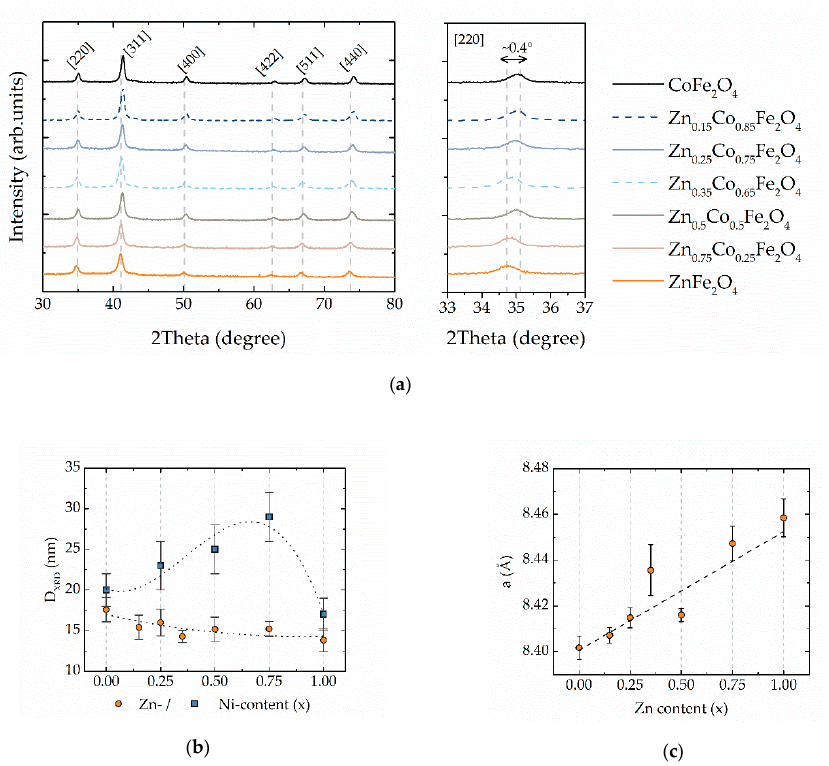
Figure 1. ( a ) diffraction patterns for all samples, in the left panel is a zoomed region for [220] reflection showing the shift of peak position; the Miller indexes for corresponding peaks are reported; ( b ) evolution of grain size (D XRD ) calculated with Scherrer formula through zinc content compared with the values obtained for Ni-Co ferrite MNPs in ref. [37]. Error bars are the standard deviation of D XRD calculated for 5 most intensive peaks; ( c ) lattice parameter ( a ) as a function of zinc